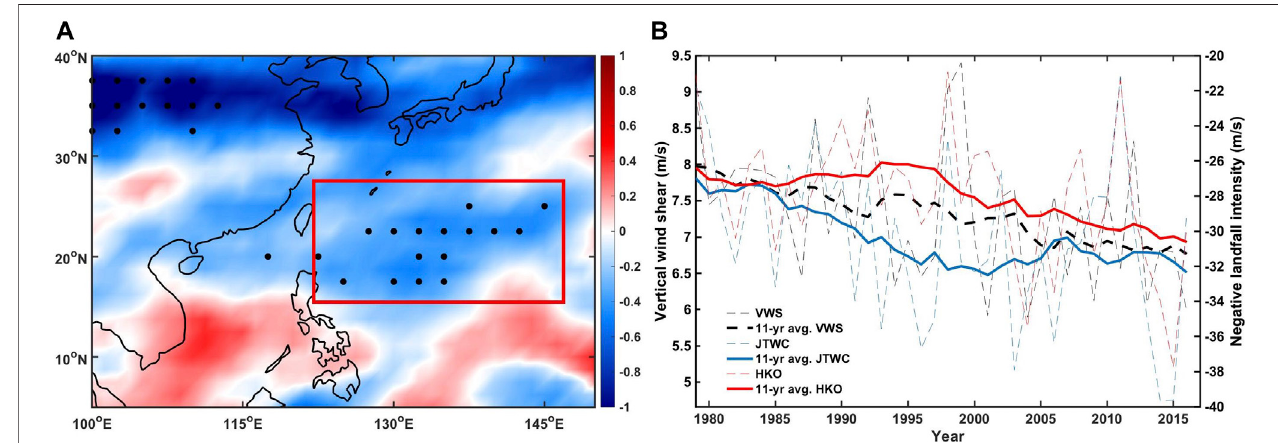
FIGURE 11 | (A) Linear trend of vertical wind shear (m/s per decade) in JJASO over WNP and the Asian region, 1979 – 2016. The area in the red box is where strongest verticalwindshearchangeoccurs.Blackdotsdenotetrendsignalspassingthe0.05signi fi cancelevelaccordingtotheMark – Kendalltest.DataarefromJRA- 55. (B) Comparison of the annual mean vertical wind shear change within the red box in (A) and the annual mean landfall intensity change. TC landfall intensities are calculated from JTWC and HKO best track datasets.